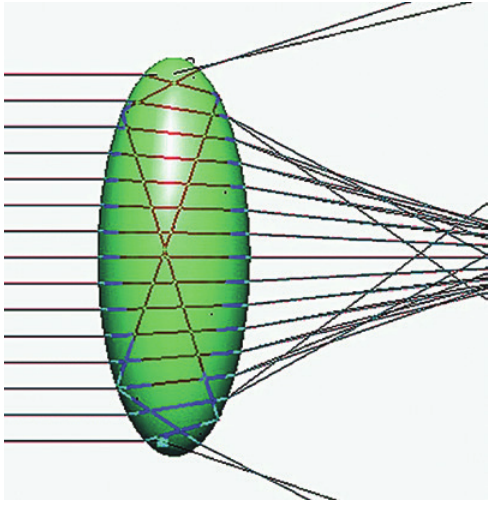
Figure 14: The ray tracing model of PS